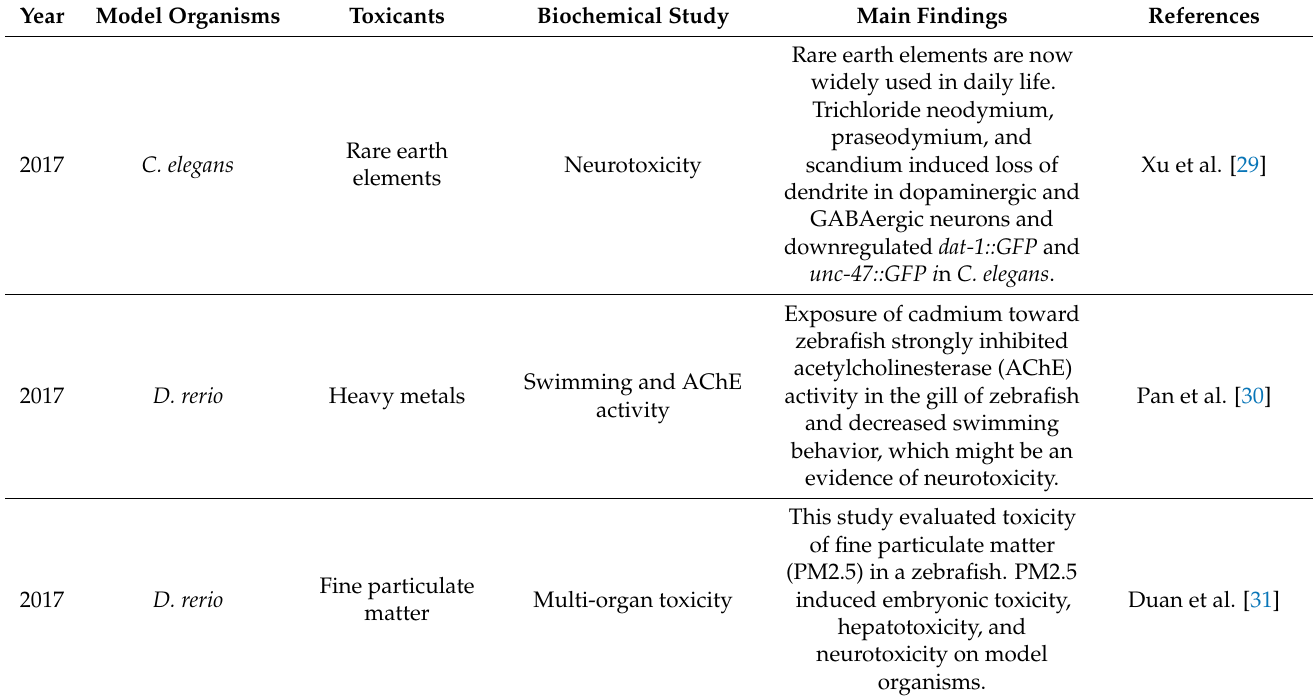
Table 1. Recent representative toxicity study in biochemical